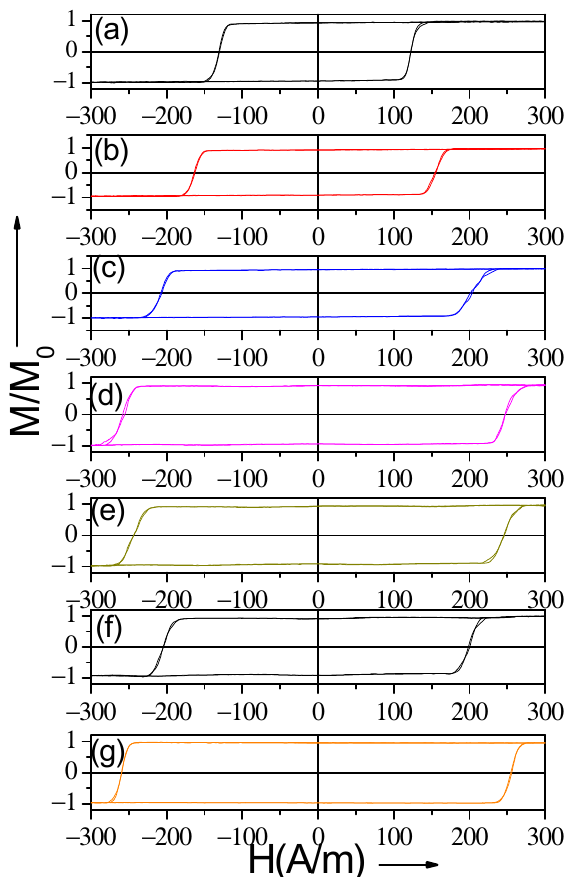
Figure 9. Hysteresis loops of as-prepared ( a ) and annealed at T ann = 410 °C for 4 min ( b ), 16 min ( c ) 32 min ( d ), 64 min ( e ), 128 min ( f ), and 256 min ( g ) Fe 62 Ni 15.5 Si 7.5 B 15 microwires. Adapted from [81].